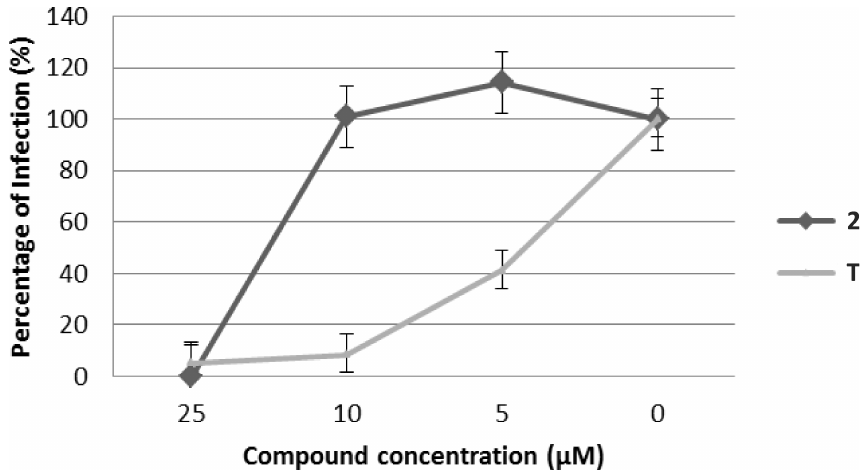
Fig 6. Anti-HIV-1 activity of compound 2 (black line) and tenofovir (T, grey line) in gel, formulation, in human TZM-bl cell line. Each concentration of both compounds was evaluated in triplicate.